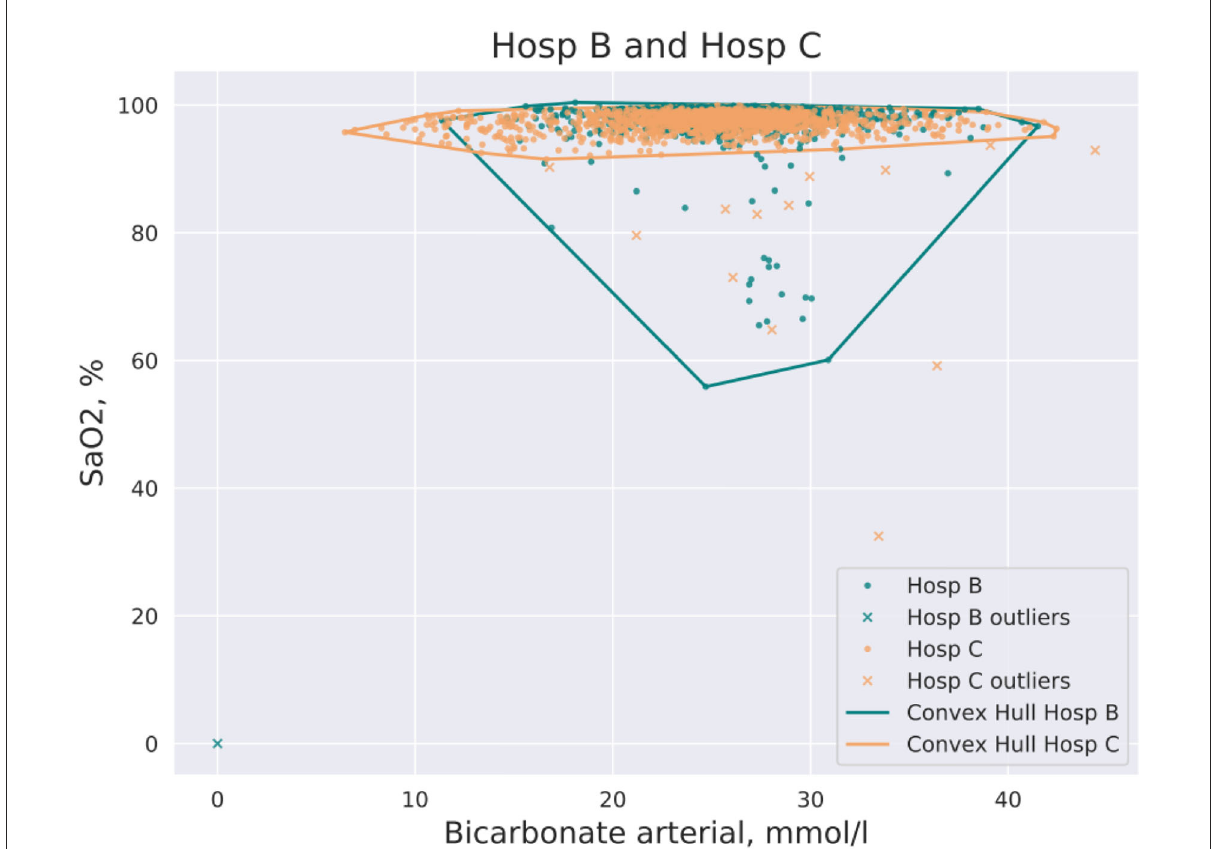
FIGURE1 Example of CH intersection for the pair of hospitals (Hosp A, Hosp B) and the pair of features: SaO 2 and bicarbonate. Some data points are filtered out by the DBSCAN method prior to the construction of the CH.